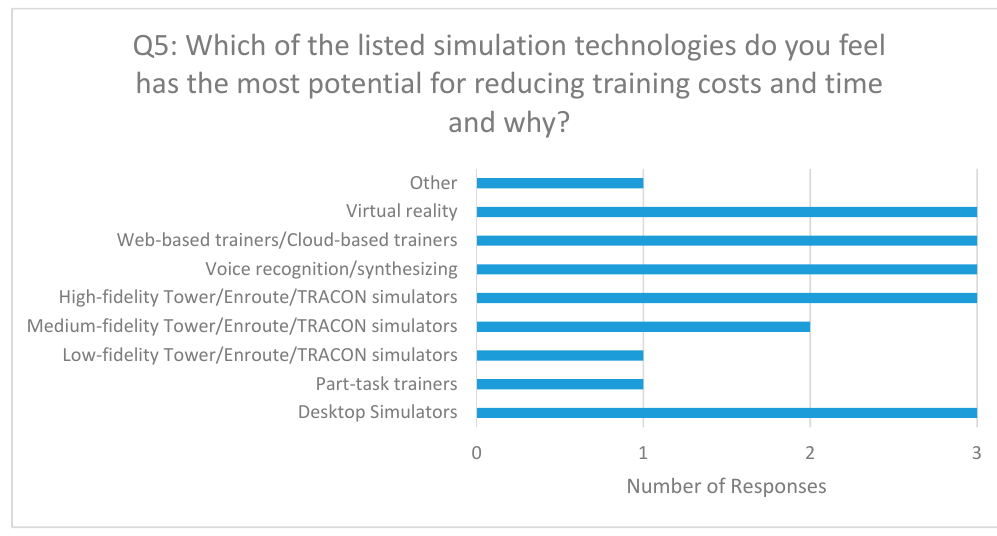
Figure 2. Technologies with the most potential for reducing training times and costs.